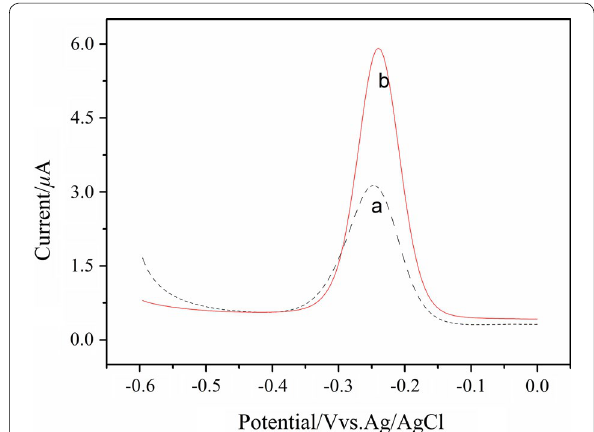
Fig. 3 DPV responses of different electrode in Tris–HCl buffer after incubated in 0.02 μM MB. (a) The cDNA/apt/AuE, (b) the CAs-cDNA/